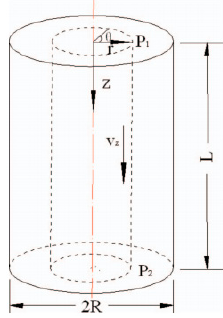
Figure 2. Cylindrical area coordinates.